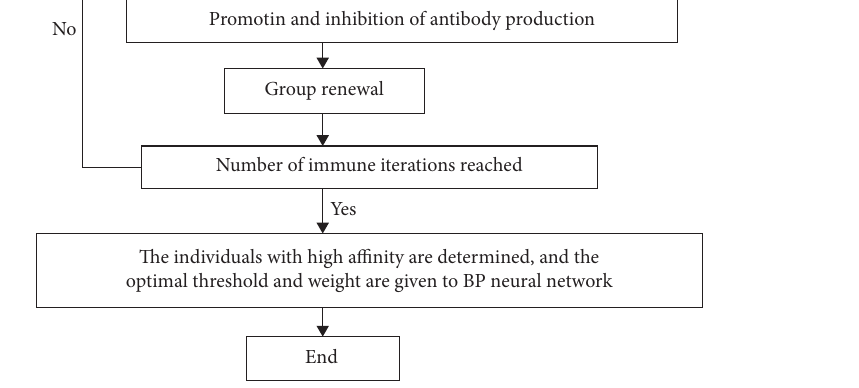
Figure 3: Stress inversion flowchart.